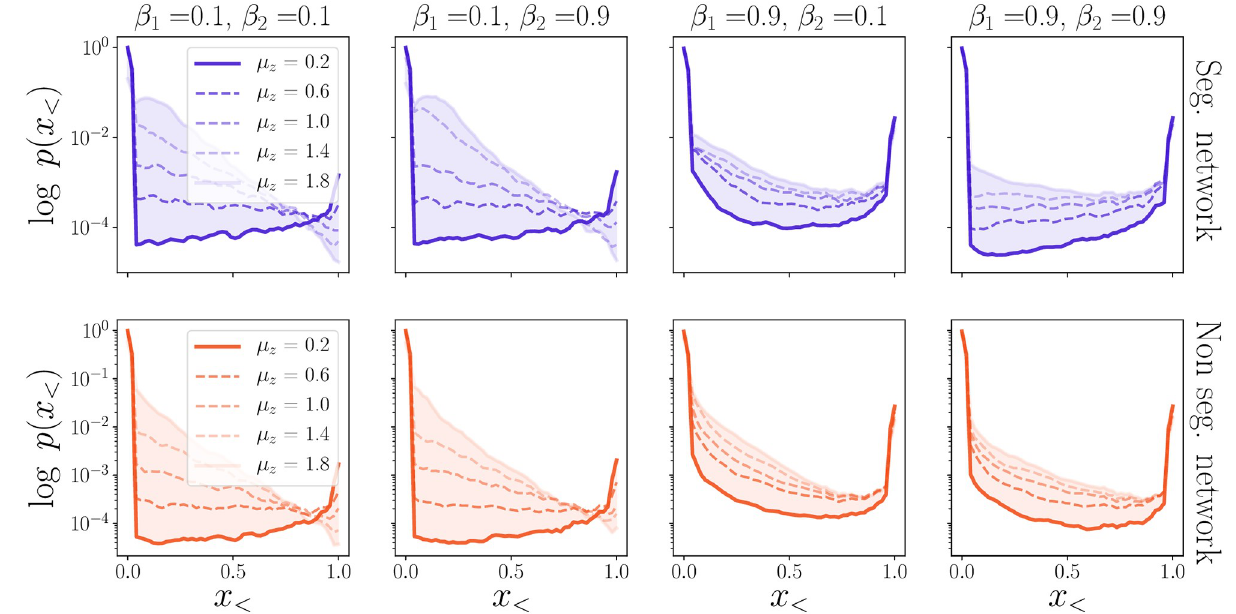
Fig 3. The panels show the probability distribution of the crisis size, x < , for different choices of the parameters. The blue curves show the results for the segregated case, λ = 0.01, while the red ones represent the non-segregated scenario, λ = 100. Each panel is dedicated to a couple β 1 , β 2 for five values of μ ranging from 0.2 to 1.8. � y ¼ 4 and � c are kept fixed. 0